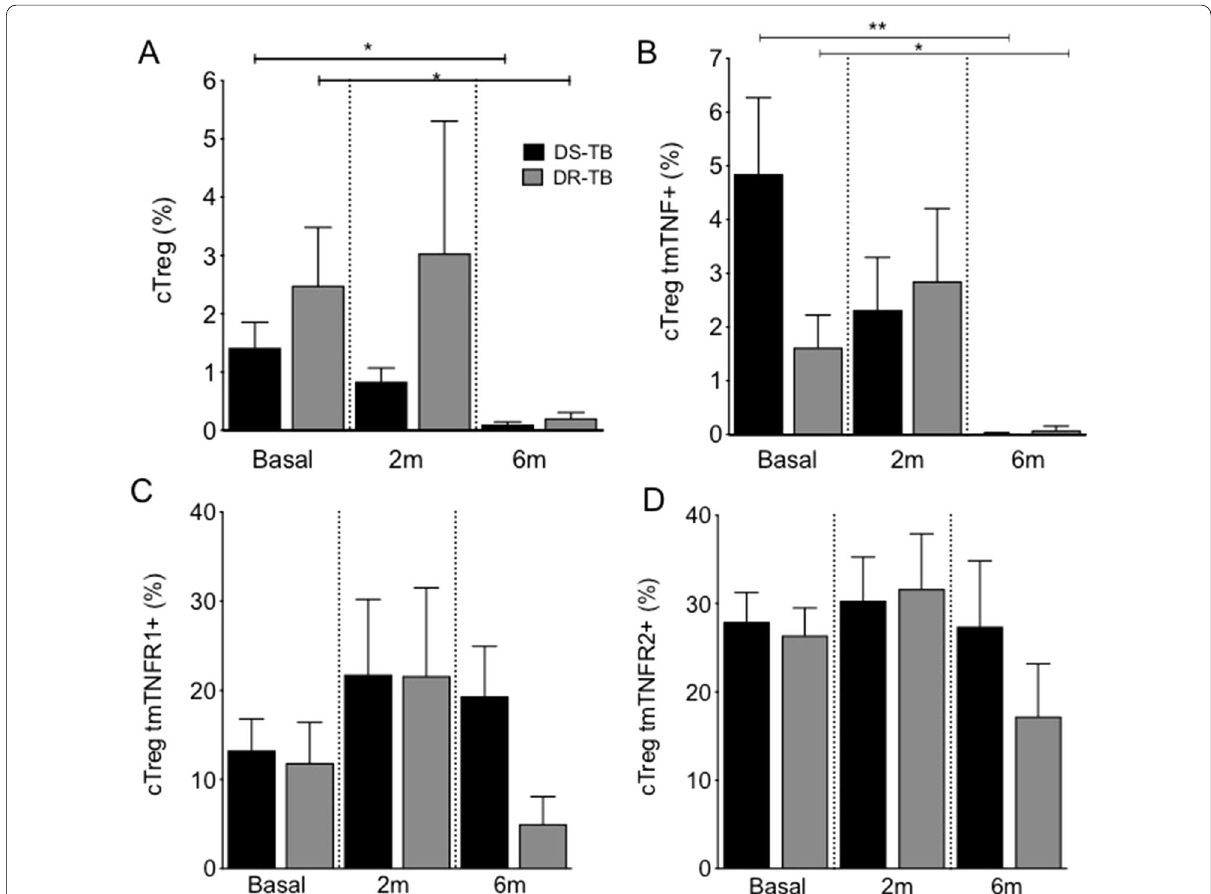
Fig. 1 cTreg and cTregTNFR are decreased in DS‑TB and DR‑TB patients in response to anti‑TB therapy. Peripheral mononuclear cells from + drug‑susceptible (DS‑TB) and drug‑resistance (DR‑TB) tuberculosis patients were obtained at diagnosis time (basal), two months (2 m), and 6 months (6 m) of use of anti‑TB therapy, and then they were prepared for flow cytometry. For analysis, a gate of CD3 CD4 CD25 Foxp3 + + + + cells (conventional regulatory T cells, cTreg) was identified. Then, the expression of tmTNF, tmTNFR1 and tmTNFR2 on the cTreg cell surface was evaluated. A The frequency of cTreg cells was obtained at basal, 2 m and 6 m of anti‑TB therapy. The frequency of cTreg positive to tmTNF ( B ), tmTNFR1 ( C ) and tmTNFR2 ( D ) was evaluated. DS‑TB n 11, DR‑TB n 7. Bar graphs showing the mean SD. One Way ANOVA with Dunn’s post‑test = = ± multiple comparisons tests (*p < 0.05 **p <